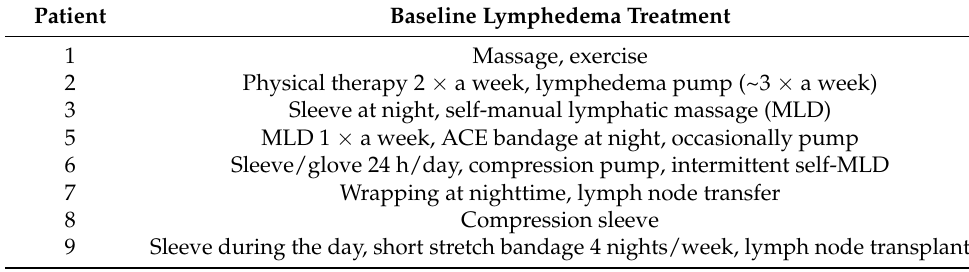
Table 5. Pre-enrollment treatment for